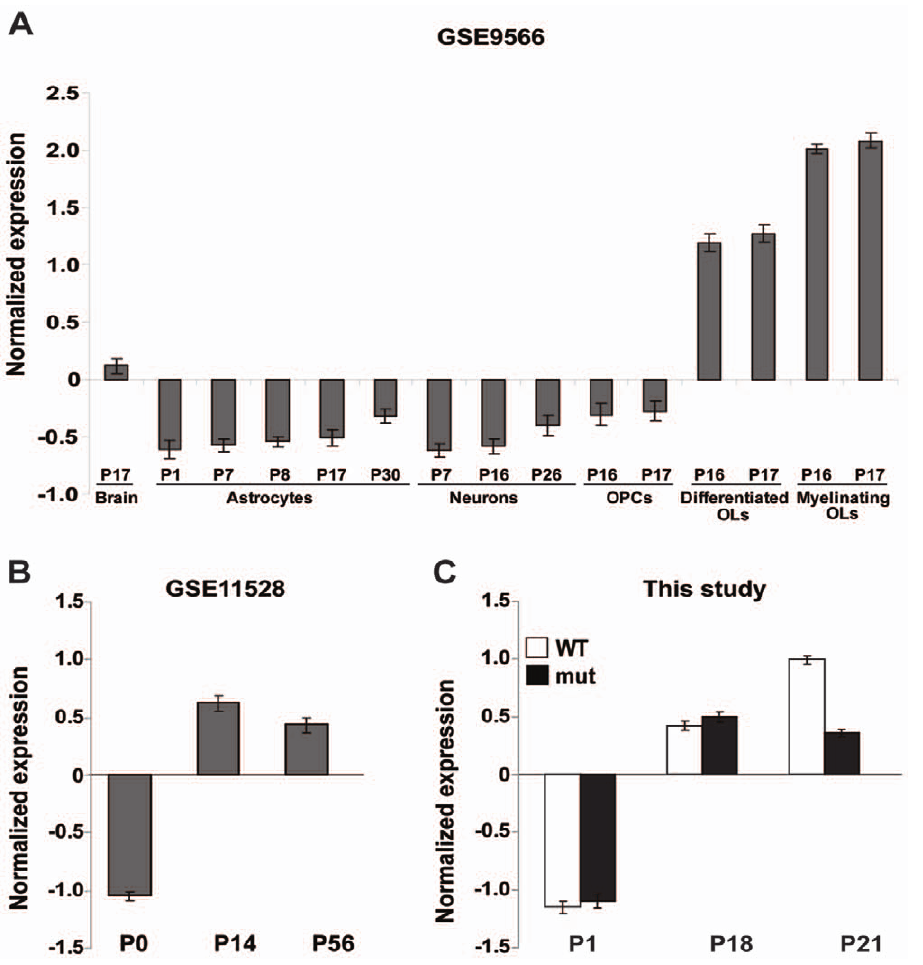
Figure 3. Expression of oligodendtocyte-related genes. Differential expression of the 52 genes with lower expression level in mutant mice at P21 that are also co-expressed in oligodendrocytes according to GEO accession GSE9566 [21] (see Materials and Methods). The expression pattern of each gene was normalized to mean=0 and standard deviation=1. (A) The average expression pattern of these genes in various brain cell types at various developmental time points as measured in [21]. (B) The average expression pattern of these genes during normal mouse brain development as measured in [19]. (C) The average expression pattern of these genes according to the current study. Error bars show one standard error.